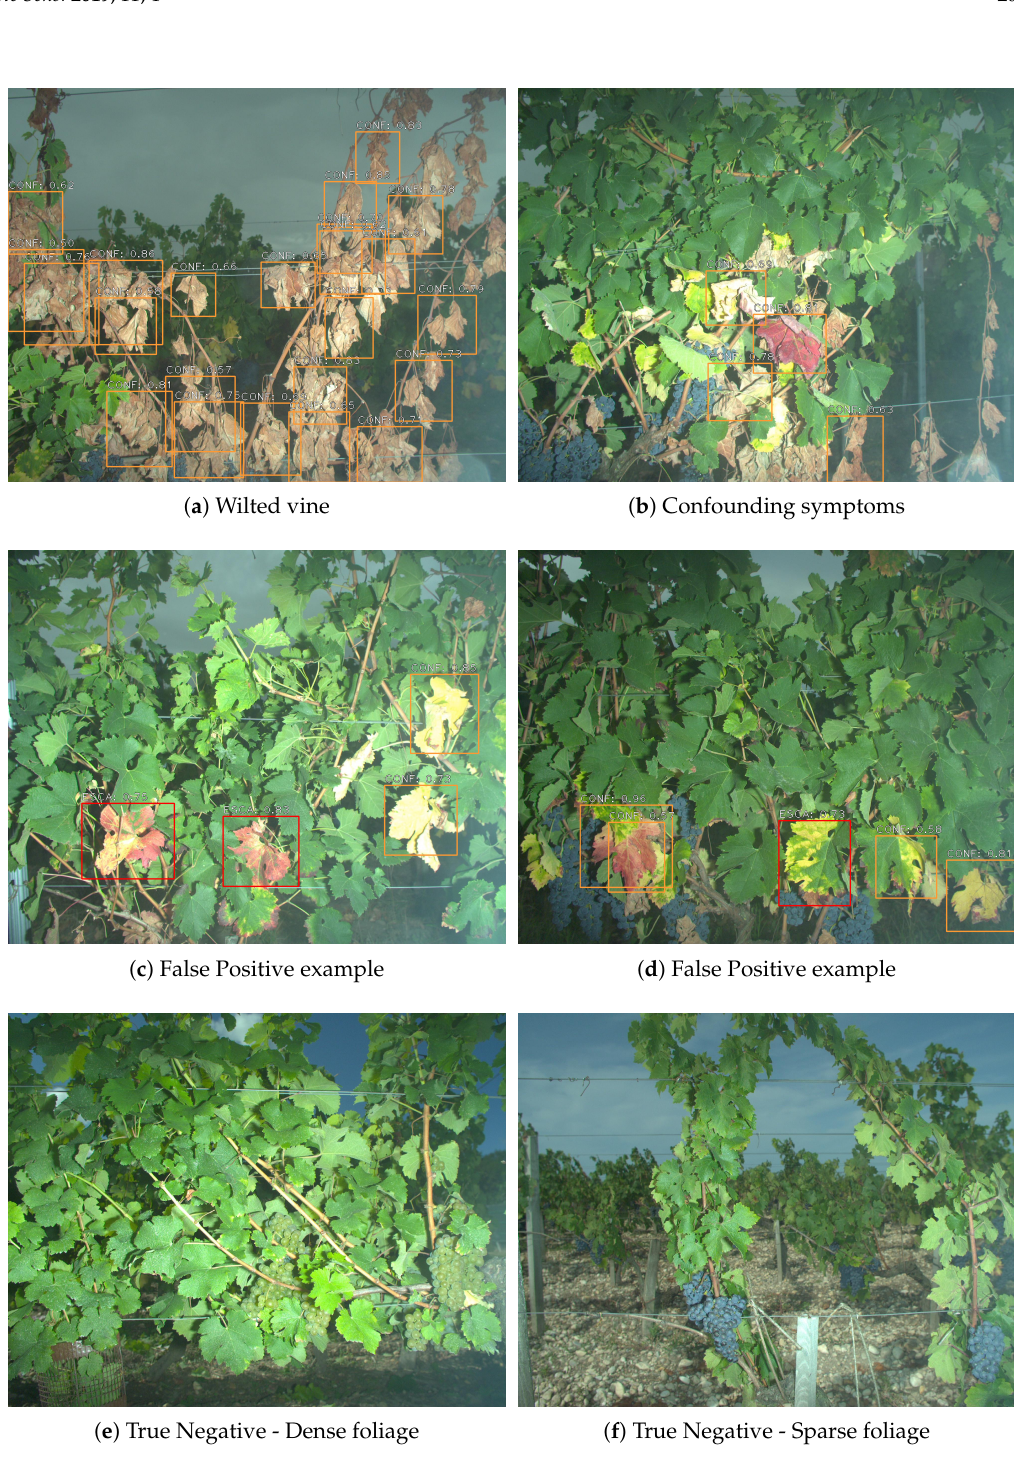
Figure 13. More segmentation examples: ( a , b ) confounding symptoms without esca false positives; ( c , d ) confounding symptoms with esca false positives; and ( e , f ) control plants with no esca false